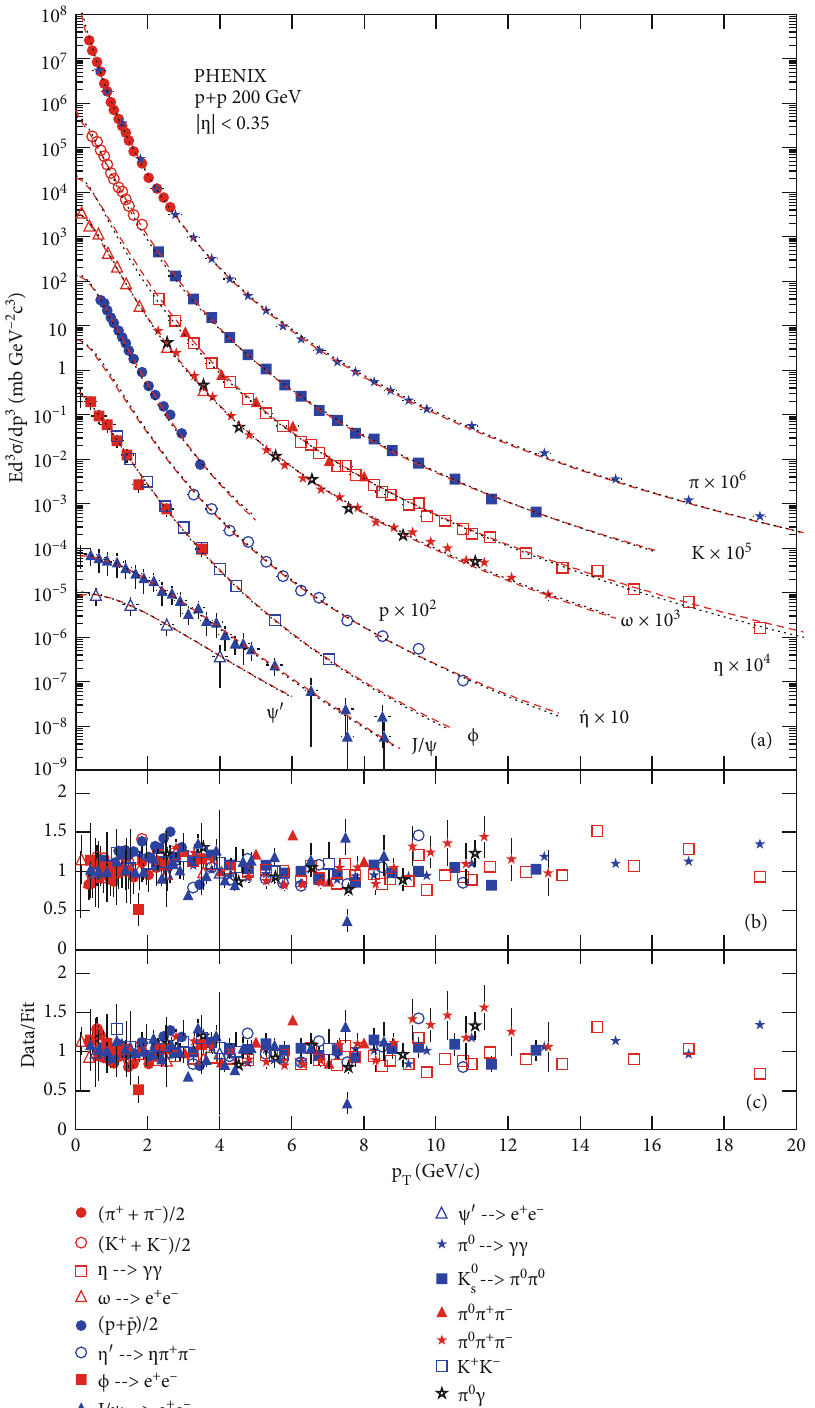
Figure 3: (a) The invariant cross-sections of various hadrons with given combinations and decay channels produced in p+p collisions at 200GeV. The symbols represent the experimental data measured by the PHENIX Collaboration [81], and the dotted and dashed curves are the fi tted results by using the revised Tsallis distribution (with the power index 1/ ð 1 − q Þ in Equation (34)) and the convolution, respectively [29]. (b) The ratio of data to fi t obtained from the dotted curves. (c) The ratio of data to fi t obtained from the dashed curves. Detailed information and related parameters can be found in ref. [29] from where the fi gure is